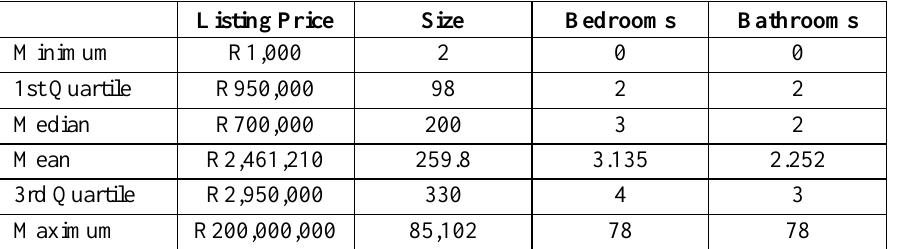
Table 2. Data Summary